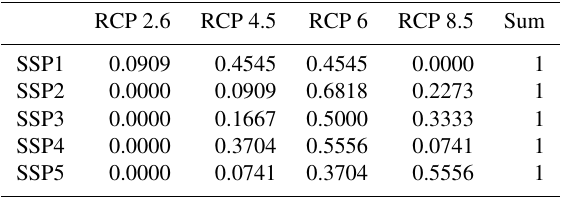
Table 4. Scenario matrix translated to quantitative